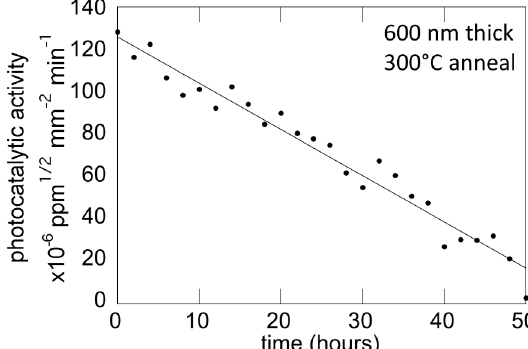
Figure 6. Photocatalytic activity as a function of time for a ZnO film having a thickness of 600 nm and annealed at a temperature of 300 ◦ C. Measurements where made spectrophotometrically over one-hour increments, with the rhoB solution being replaced after each one-hour